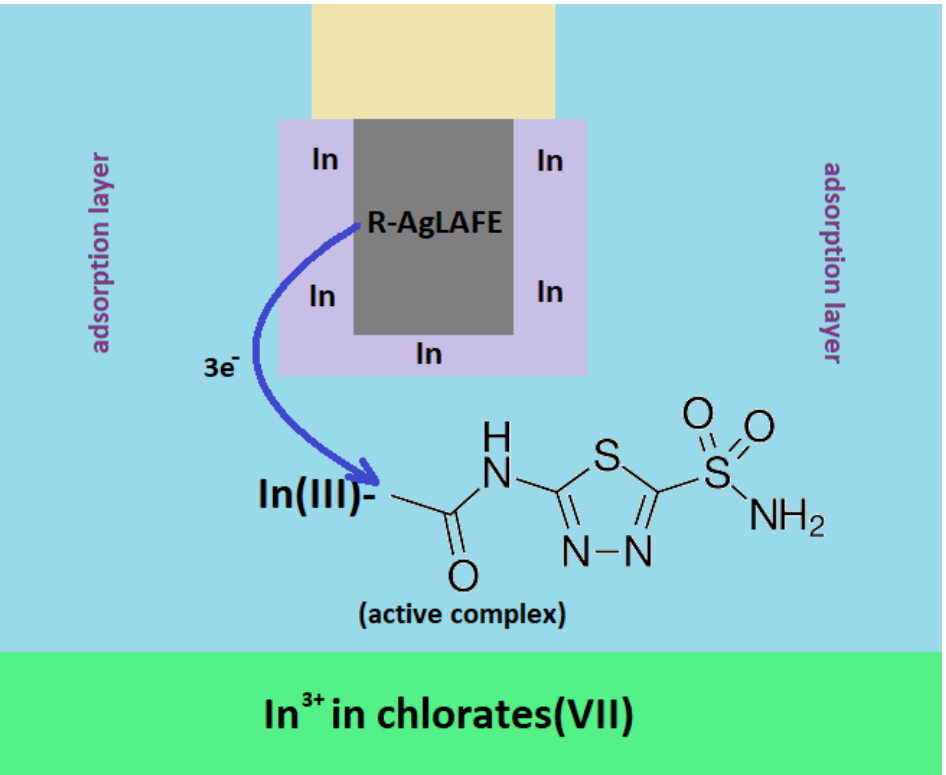
Figure 6. Scheme of In(III) ions electroreduction in chlorates(VII) including the mediating role of active complexes in the charge (electron)